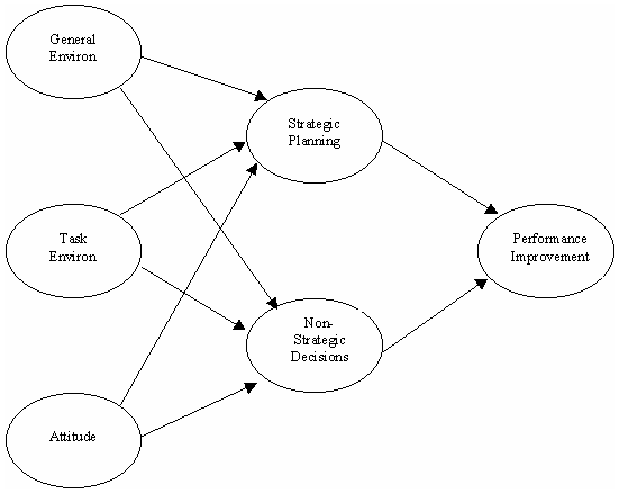
Figure 1: Research model (arrows represent hypothesized